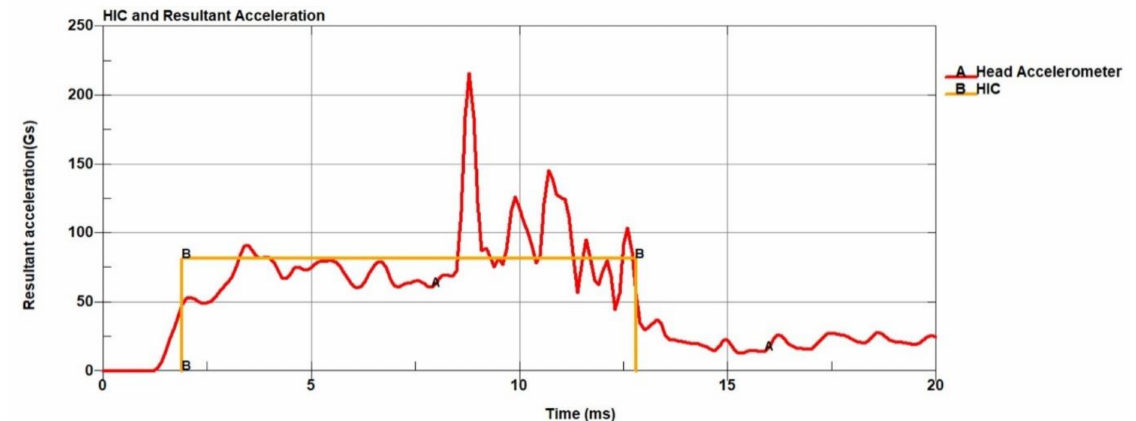
Brain Sci. 2021 , 11 , x FOR PEER REVIEW Figure A2. HIC and Resultant Acceleration (g) in time (ms) plot (HIC = 650).